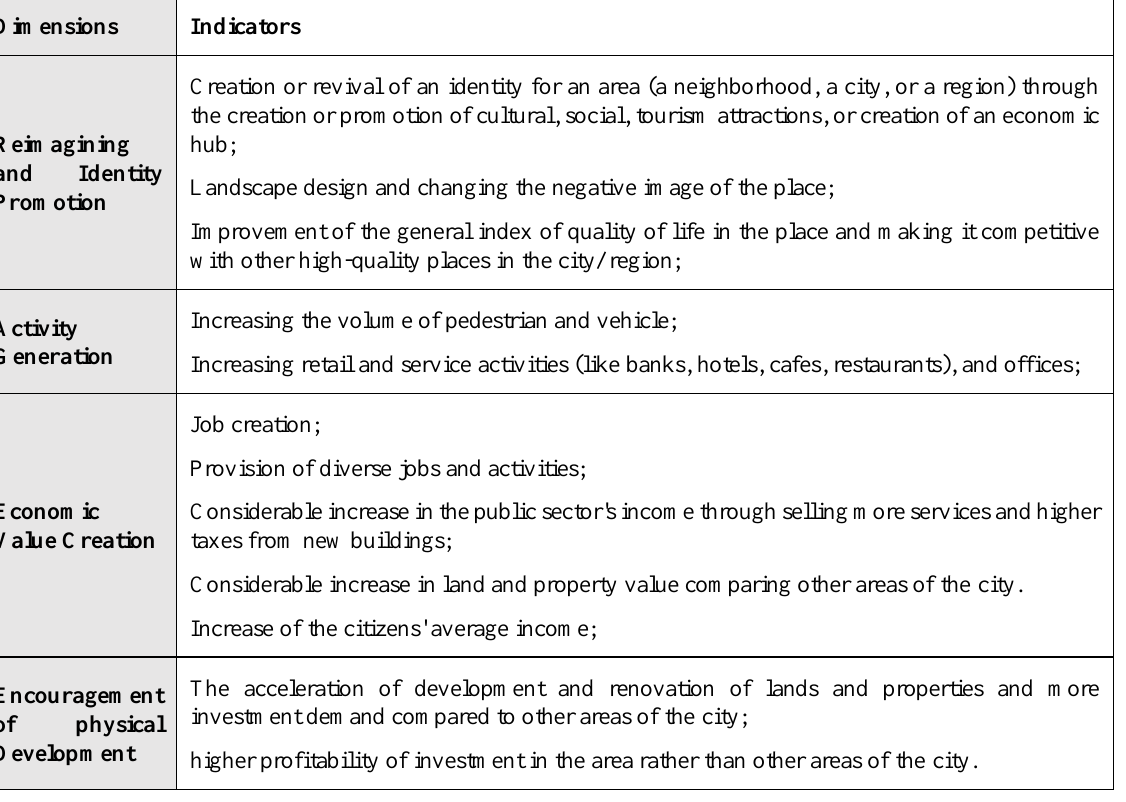
Table 1. Dimensions of Urban